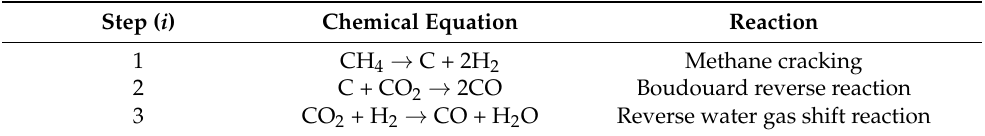
Table 1. Steps of the reaction for dry methane reform DRM